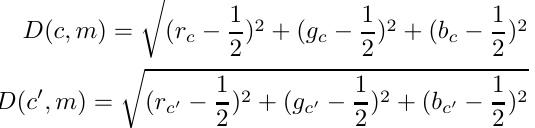
Fig. 3. The RGB colour cube with the plane V (in green) and the line l (in